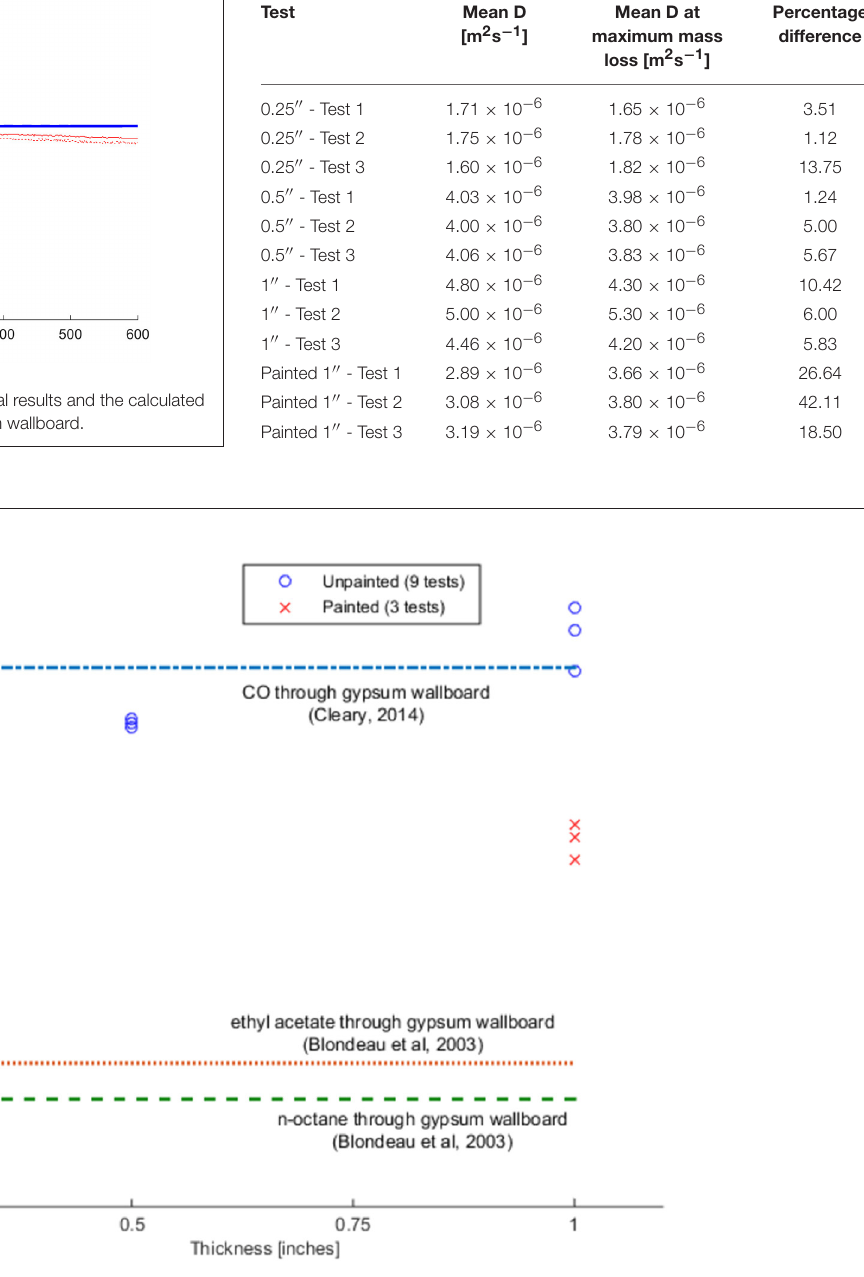
Frontiers in Built Environment |